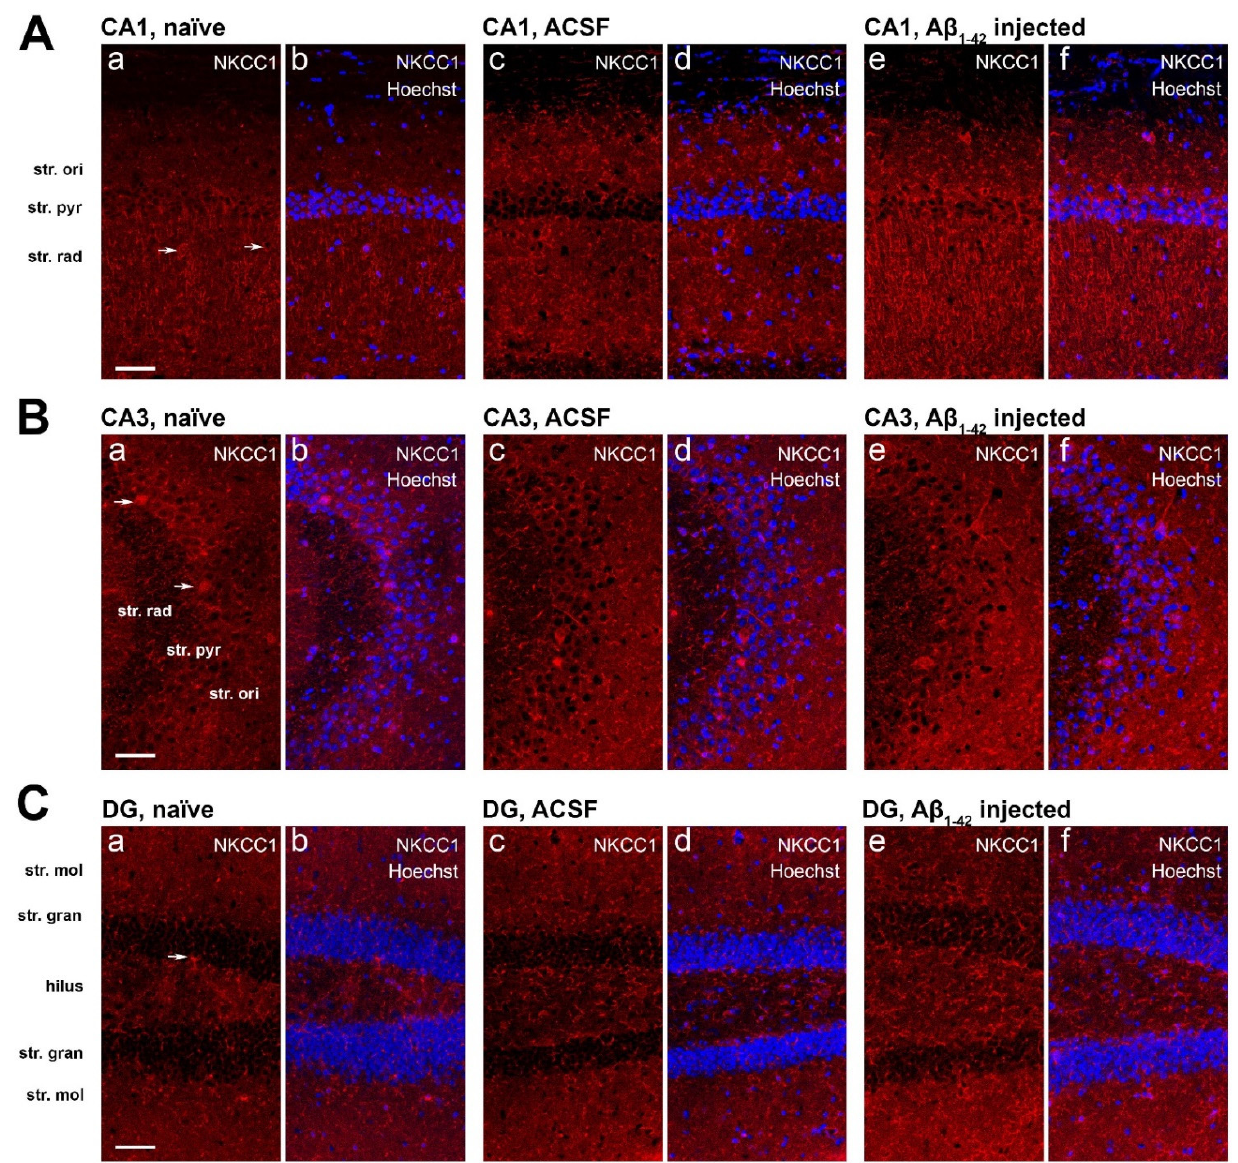
Figure 9. NKCC1 expression in the mouse hippocampus. Confocal images of mouse hippocampal sections showing the immunofluorescence of NKCC1 (red) and Hoechst 33,342 (blue) in the ( A ) CA1, ( B ) CA3, and ( C ) DG of naïve ( a , b ), ACSF ( c , d ), and A β 1-42 -injected mice ( e , f ). Arrows indicate NKCC1 is expressed on neuronal cell bodies in the CA1, CA3, and DG. Scale bar = 50 µ m. In the CA1 region of the A β 1-42 -injected mice NKCC1 immunoreactivity significantly increased in the str. oriens compared to naïve controls (** p = 0.0034, n = 5), ACSF (** p = 0.0082, n = 5), and scrA β -injected mice (** p = 0.0037, n = 5). In the str. pyramidale and str. radiatum NKCC1 expression levels were greater in A β 1-42 -injected mice compared to naïve (*** p = 0.0003 and * p = 0.0117, n = 5), ACSF (*** p = 0.0004 and * p = 0.0128, n = 5), and scrA β (*** p = 0.0002 and ** p = 0.0085, n = 5) groups 30-days post- A β 1-42 -injection, respectively (Figure 10A). As for KCC2, the effect of A β 1-42 on NKCC1 expression is local- ized to the CA1 injection site but more extended as NKCC1 expression appears to increase specifically around the needle track (Figure